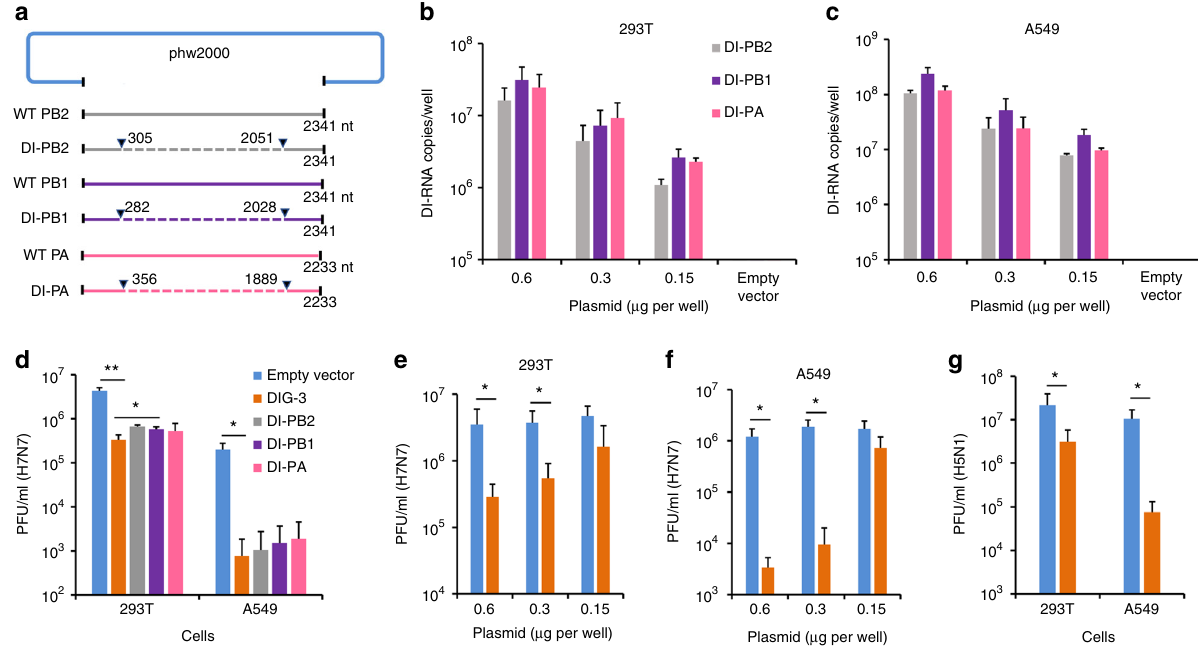
Fig. 1 Construction and antiviral activity of defective interfering genes (DIG). a The plasmid construction of DI-PB2, DI-PB1, and DI-PA. The indicated sequences of shortened viral polymerase gene PB2, PB1, and PA were inserted into phw2000, respectively. Dotted lines indicate the internal deletion of wild-type (WT) viral polymerase genes. b , c DI RNA expression in 293T and A549 cells. The plasmids of DI-PB2, DI-PB1, and DI-PA were co-transfected into cells with the indicated concentrations. At 24 h post transfection, DI RNAs were extracted from cells and digested by DNase I for RT-qPCR. Empty vector was used as a negative control for RT-qPCR. d Anti-A(H7N7) virus activity of individual plasmid of DI-PB2, DI-PB1, and DI-PA or three combined plasmid DIG (DIG-3, 0.6 μ g per well). e , f Dose-dependent anti-A(H7N7) virus activity of DIG-3 in 293T and A549 cells. g Anti-A(H5N1) virus activity of DIG-3. Empty vector phw2000 and plasmids with DIG were individually transfected to cells. At 24 h post transfection, cells were infected with A(H7N7) or A(H5N1) virus at MOI = 0.005 and cell supernatants were collected at 40 h post infection. Viral titers in the supernatants were detected by plaque assay. Data were presented as mean ± SD of three independent experiments. * Indicates P < 0.05. ** Indicates P < 0.01. P values were calculated by the